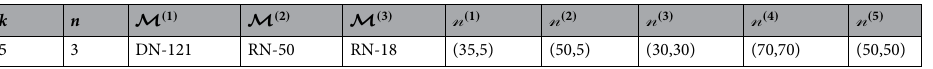
Table 4. Parameters used to test untrainable data cleansing (algorithm 1) on cats and dogs dataset. ‘RN’ stands for ResNet 23 and ‘DN’ stands for DenseNet 24 neural network architectures, respectively.